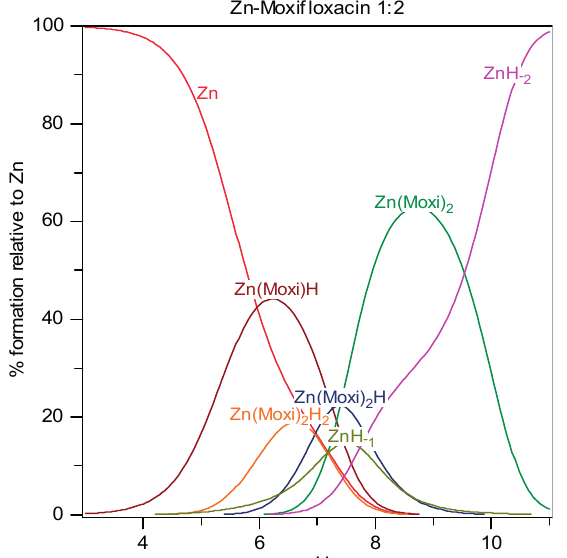
Figure 5. Distribution diagram of Zn-moxifloxacin species at ligand-to-metal concentration ratio 2:1 and total metal concentration 1.0